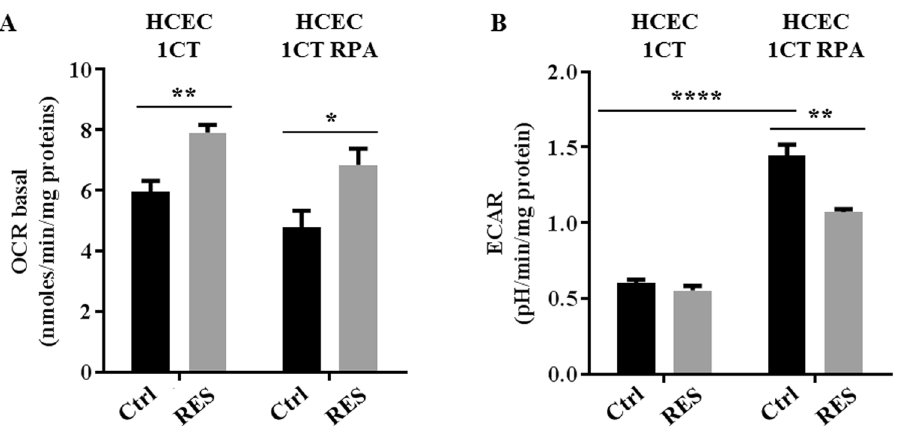
Figure 3. Resveratrol promotes a shift from respiration to glycolysis in cancer-like cells, but not in normal colonocytes. HCEC 1CT and HCEC 1CT RPA cells were treated with 10 µ M resveratrol (RES) for 48 hr and then OCR ( A ) and ECAR ( B ) were estimated using Seahorse technology, as described in the Material and Methods section. The means ± SEM are shown for at three independent experiments performed in quadruplicate ( * p < 0.05, ** p < 0.01, **** p < 0.0001 vs